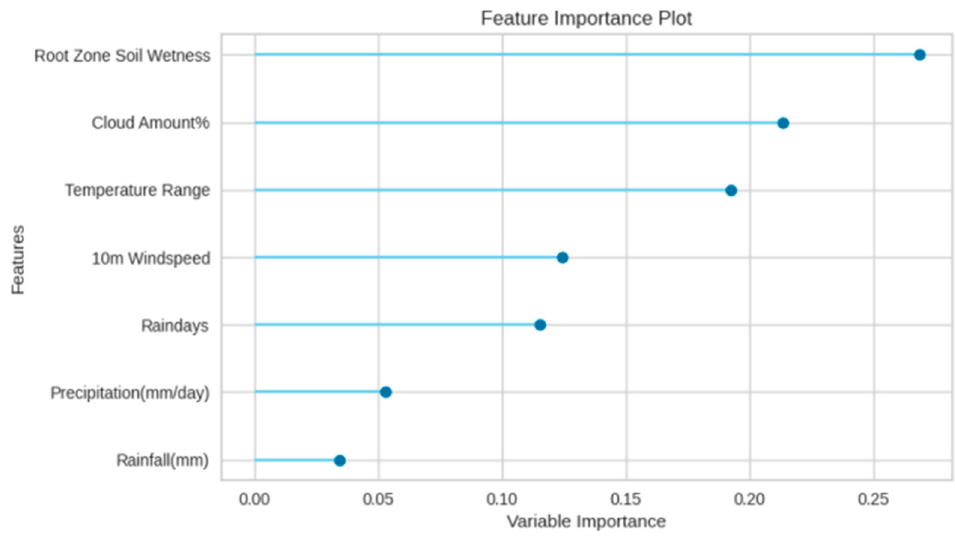
Figure 6. Feature importance plot of AdaBoost.